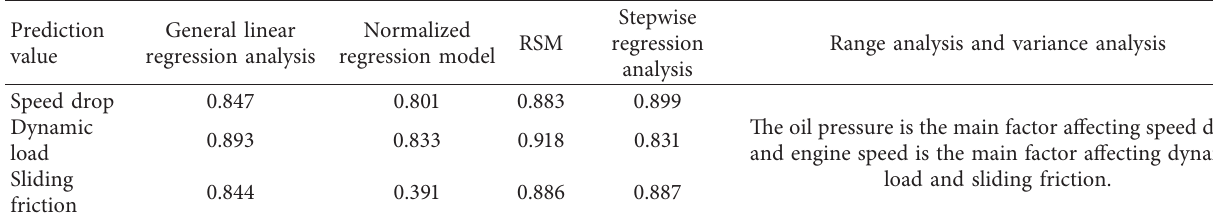
Table 11: Comparison of predication results of different modeling methods.